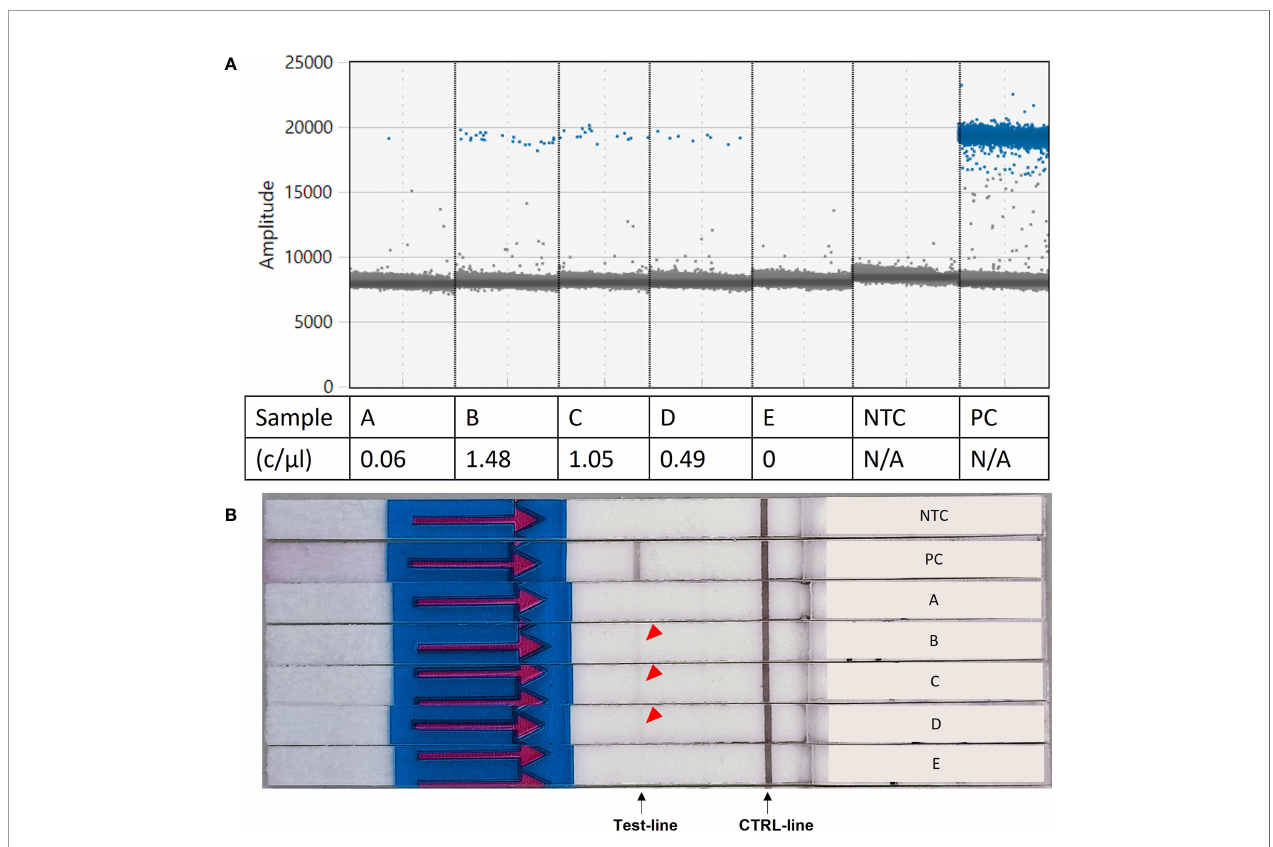
FIGURE 5 | Results of the Recombinase Polymorphism Ampli fi cation-Lateral Flow (RPA-LF) assay test on environmental samples. (A) Environmental samples tested for Sabella spallanzanii using digital droplet PCR and reported concentrations. (B) Results of the RPA-LF assay performed on the same environmental samples, showing ampli fi cation for samples B – D (red arrow). c/mL,copies per mL; NTC, no template control; PC, positive control; N/A, not